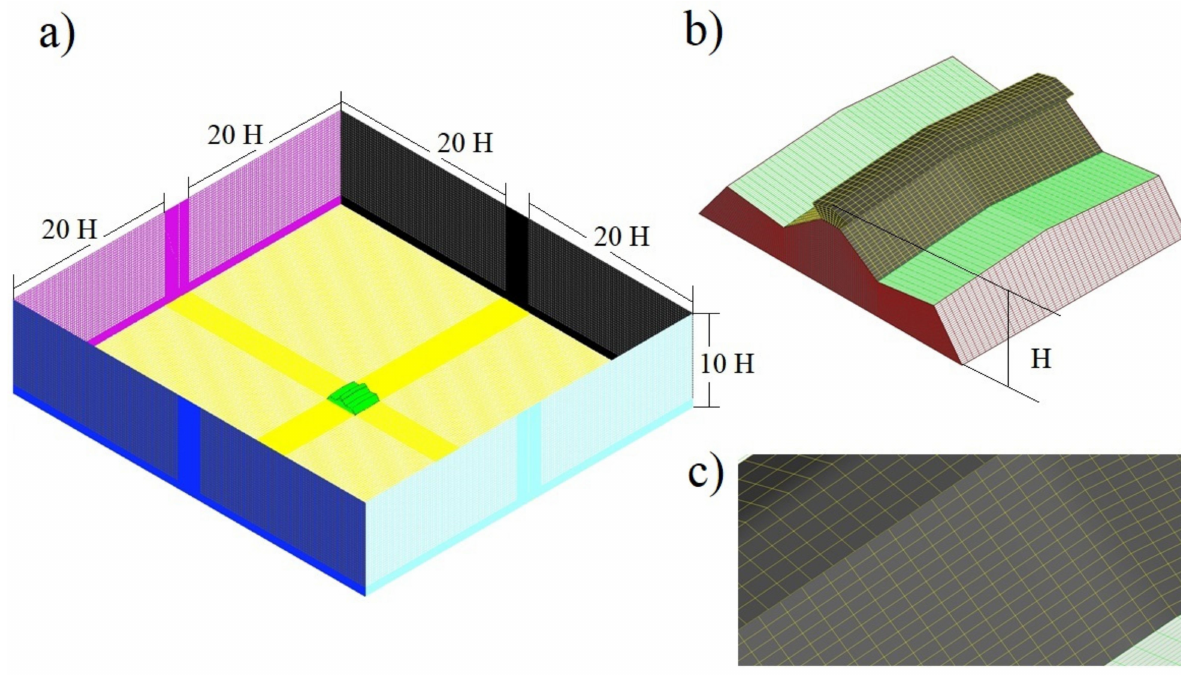
Figure 3. ( a ) size of the computational domain, ( b ) grid of the structure and ( c ) detail of the numerical grid of the